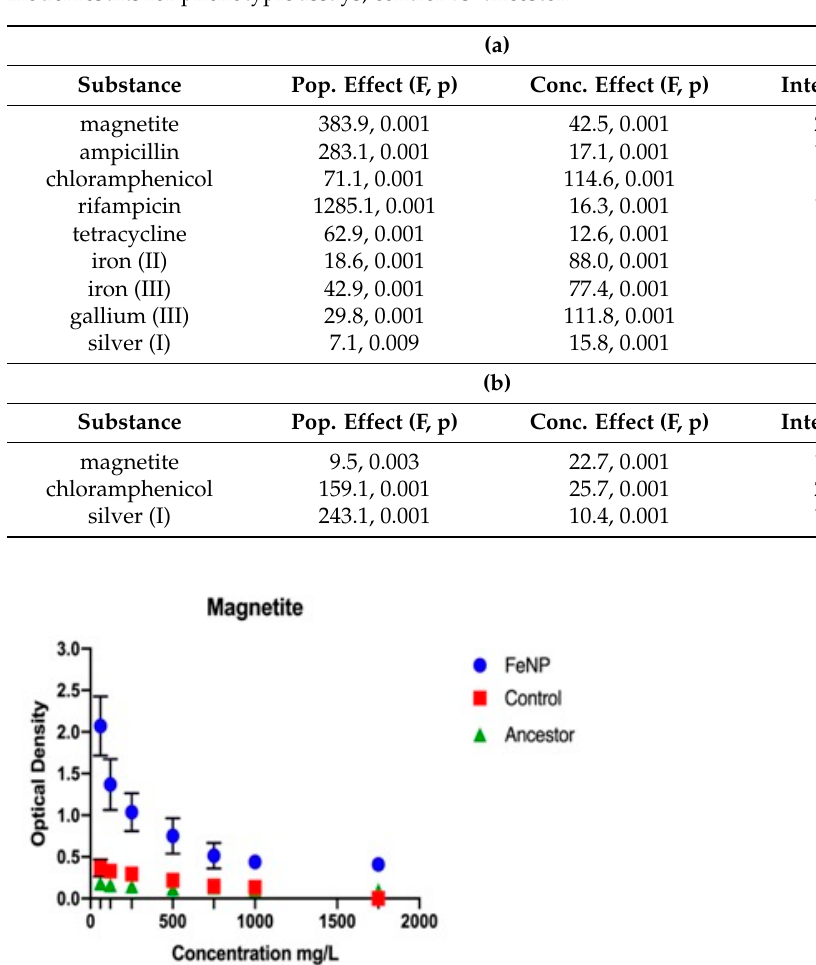
Table 2. ( a ) General linear model results for phenotypic assays, FeNP vs. Control. ( b ) General linear model results for phenotypic assays, control vs. ancestor.